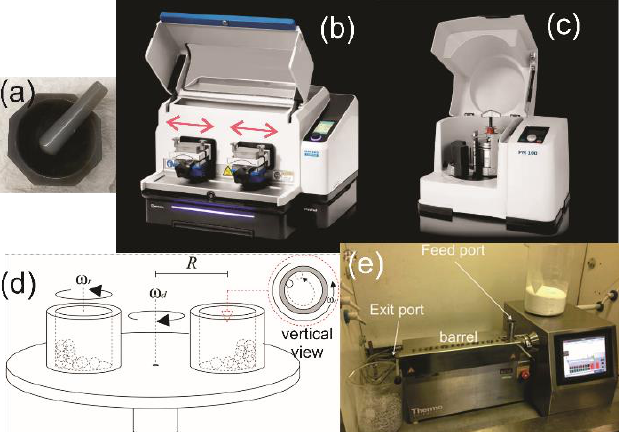
Figure 1. Examples of laboratory equipment and instruments commonly used in mechanochemistry. ( a ) An agate mortar and pestle for manual grinding. ( b ) A Retsch GmbH (Haan, Germany) mixer-type ball mill model MM 500 with optional temperature control capability. The pink horizontal arrows (drawn on the photograph) indicate the oscillatory movement of the reaction jars. ( c ) A Retsch GmbH (Haan, Germany) planetary ball mill model PM 100. ( d ) Schematics of the operation mode of a planetary ball mill. The support disc at the bottom rotates with ω d frequency as indicated by the arrow. Two reaction jars, in which individual rotational axes are placed at R distances from the central axis, each rotate with ω r frequency in a direction opposite to that of the support disc. A vertical view of a reaction jar (right side) shows a ball’s trajectory. Scheme reproduced from reference [9] with permission. ( e ) A twin-screw extruder. The reactants are introduced through the feed port, the reaction occurs in the barrel, and the products are obtained in the exit port. Figure reproduced from reference [10] with